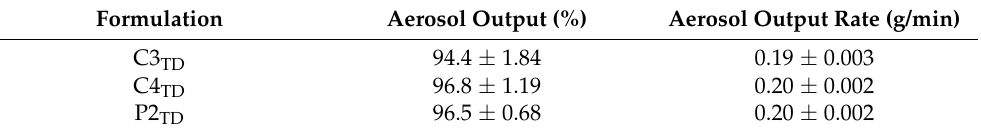
Table 6. Nebulization performance of 50-fold saline diluted TD-NEs using Microlux ® jet nebulizer.